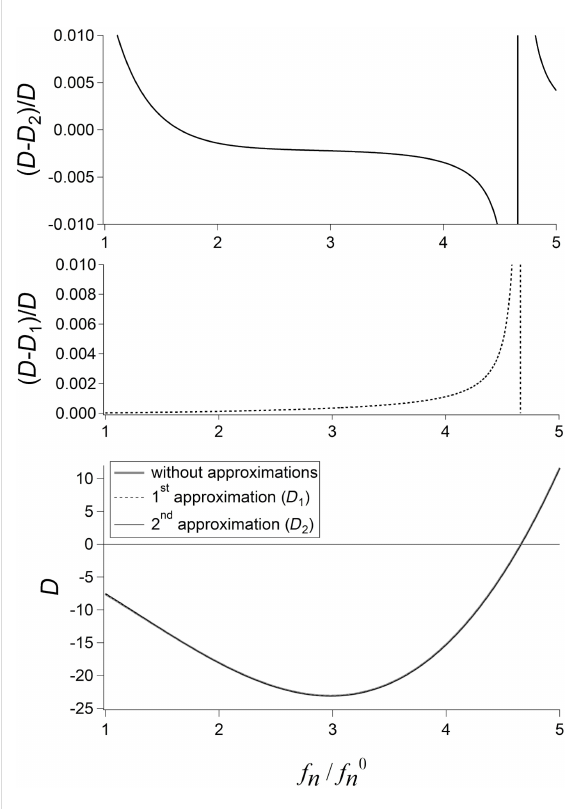
Figure 1: The function D without approximations (Equation 2) and with both approximations (Equation 4 and Equation 5) for γ = 0.97. The top part of the figure shows the differences between both approximated functions and the exact one, divided by the exact